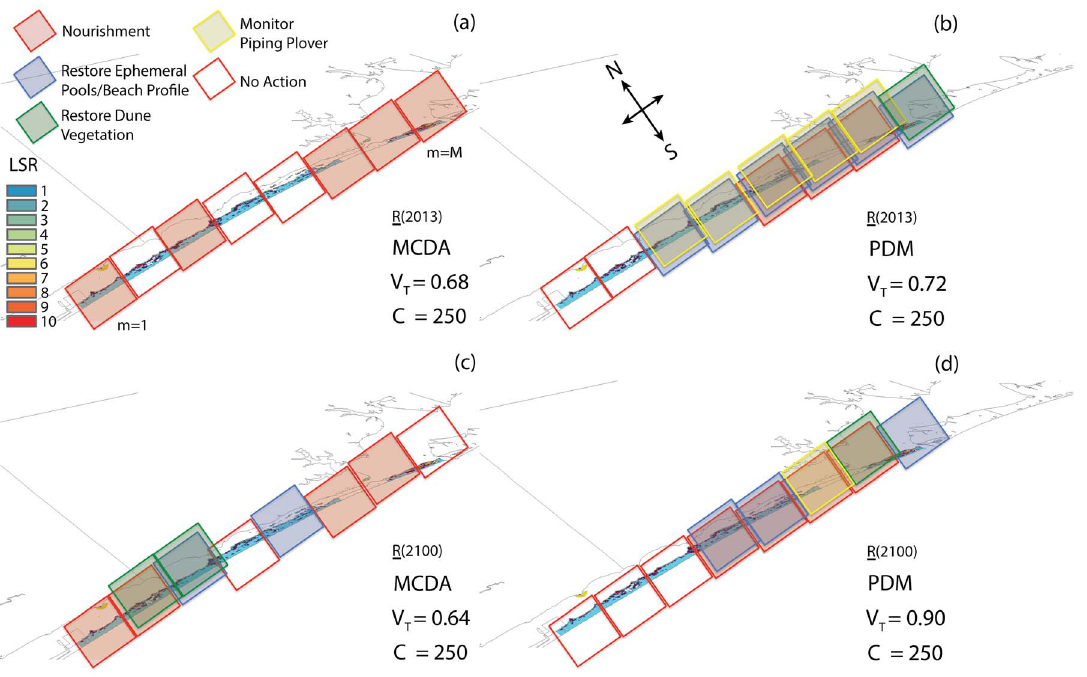
Figure 5. Restoration plans for Santa Rosa Island for the MCDA and PDM. Restoration plans are shown for 2013 (a, b) and 2100 (b, d) after the MCDA and portfolio decision model (a, c, and b, d respectively). The size of each management area is 3750 m 2 . The total cost of the selected restoration actions is 250 resource units that is the budget available. doi:10.1371/journal.pone.0065056.g005 suboptimal solutions of Figure 4a with B= 250. The relative importance of human versus natural assets can be decided according to stakeholder preferences, or perhaps by legal